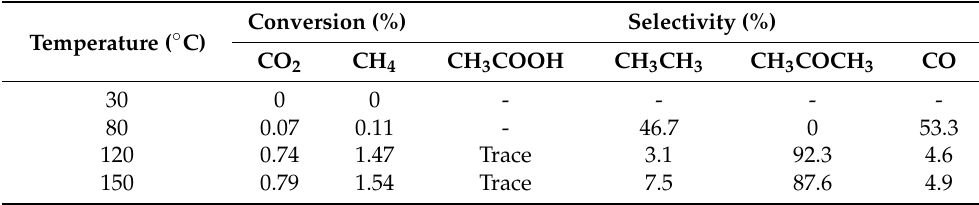
Reaction conditions = 1 atm, CO2/CH4 = 1/1 (molar ratio), UV intensity = 20.0 mW cm − 2 , space ve- locity = 200 h − 1 .